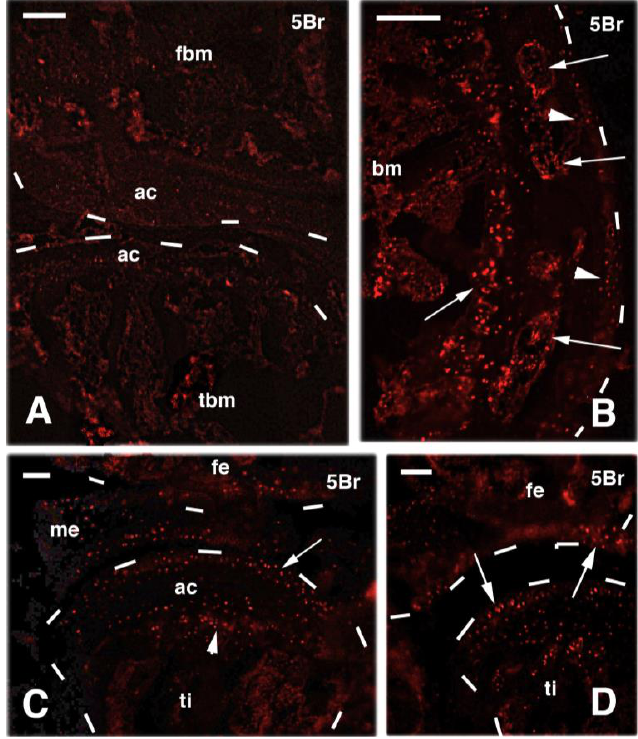
Figure 2. TRITC immunofluorescence (red) of normal knees 4 h after injection of 5BrdU. ( A ) both femur (top) and tibia (bottom) epiphyses contain very few labeled cells (red dots) in this case. Bar, 50 μm; ( B ) detail on another case of normal knee showing more numerous labeled cells in both the articular cartilage surface (arrowheads) and within secondary centers of ossification in the epiphysis (arrows). Bar, 25 μm; ( C ) other case of normal knee showing numerous and regularly distributed labeled cells in both the articular cartilage of the tibia (arrow) and in its growth plate (arrowhead). Bar, 50 μm; ( D ) another case with more irregular distribution of labeled cells (arrows) in the femur (top) and tibia (bottom). Bar, 25 μm. Legends: ac, articular cartilage; bm, bone marrow; fbm, bone marrow of the femur; fe, femur; me, meniscus; tbm, bone marrow of the tibia; ti, tibia. The dashes outline the bone shape.